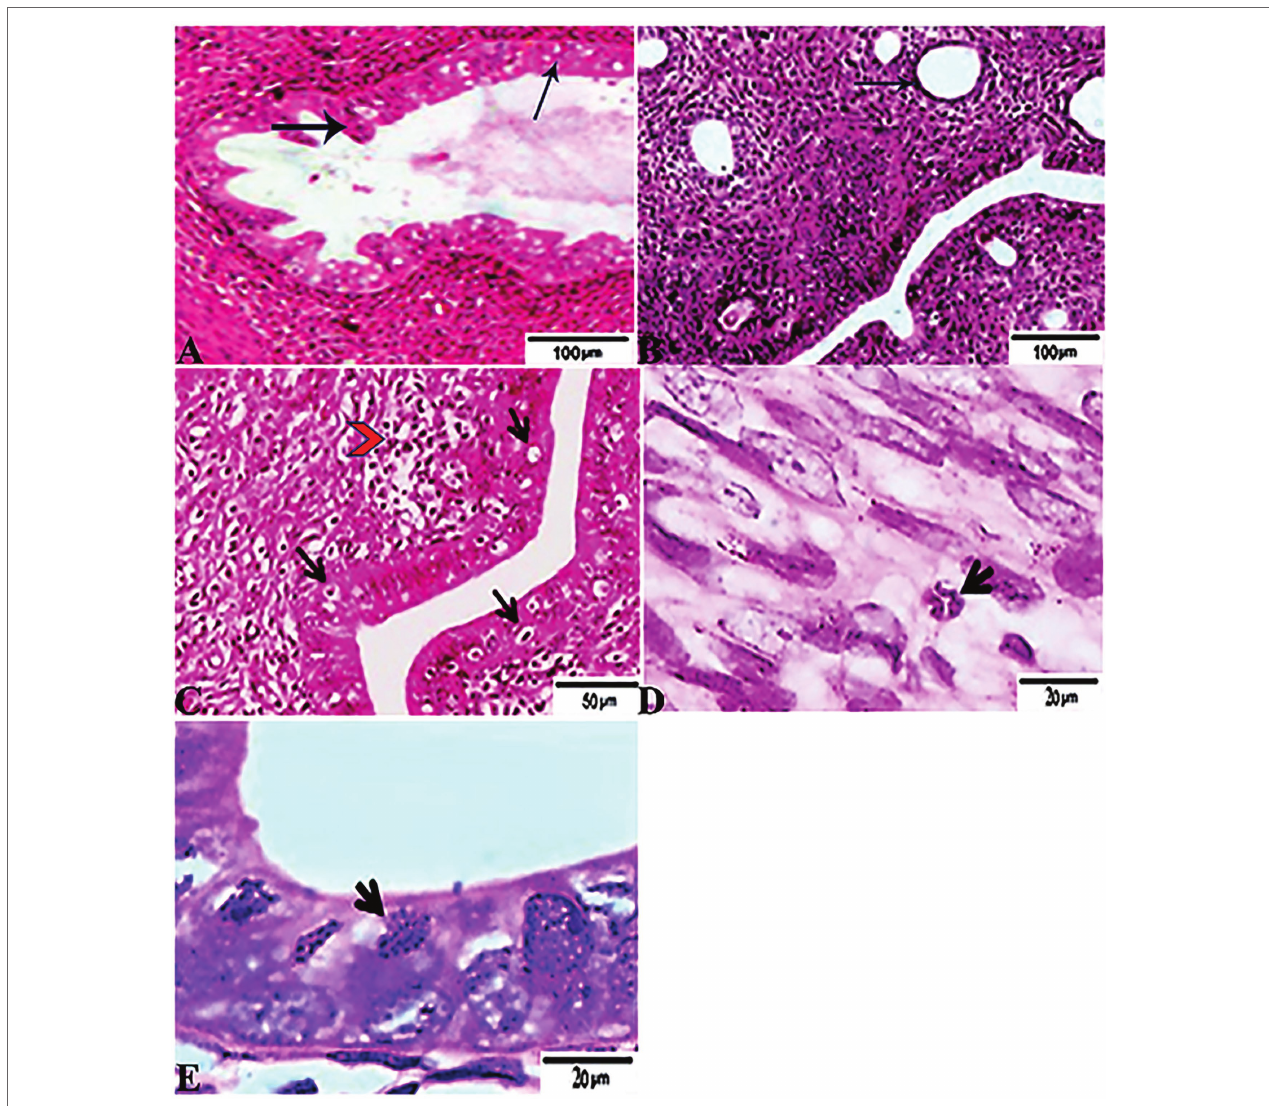
FIGURE 5 | Photomicrograph of Uterus sections from experimental mice groups stained with Hx&E stain: (A,B) a mice uterus from the control group demonstrating normal uterine architectures. (A) Normal endometrial epithelium (arrows). (B) Normal endometrial glands (arrow). (C) Uterine tissue section from control positive group infected by Toxoplasma gondii showing; severe endometrial necrosis appeared as diffuse nuclear pyknosis in most of the endometrial epithelium (arrows), severe mononuclear cellular infiltration (red arrowheads). (D) Uterus sections from the treated group for 14 days showed: tachyzoites infestation in connective tissue stroma of the endometrial lamina propria submucosa (arrow). (E) Uterine tissue section from the treated group for 28 days showing: exhibited the presence of a cluster of tachyzoites intracellularly in the lining epithelium of endometrium (arrow). The bar size of each picture was indicated under each